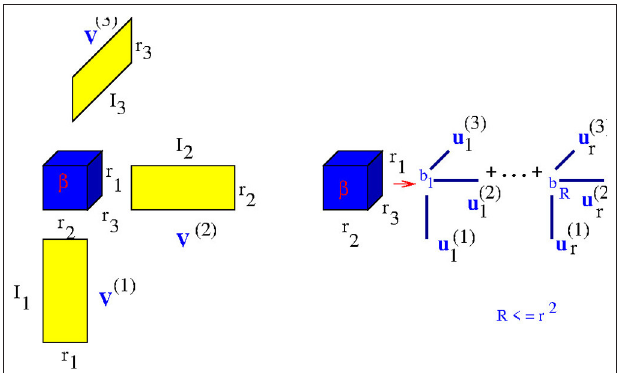
FIGURE 3 | Mixed Tucker-to-canonical